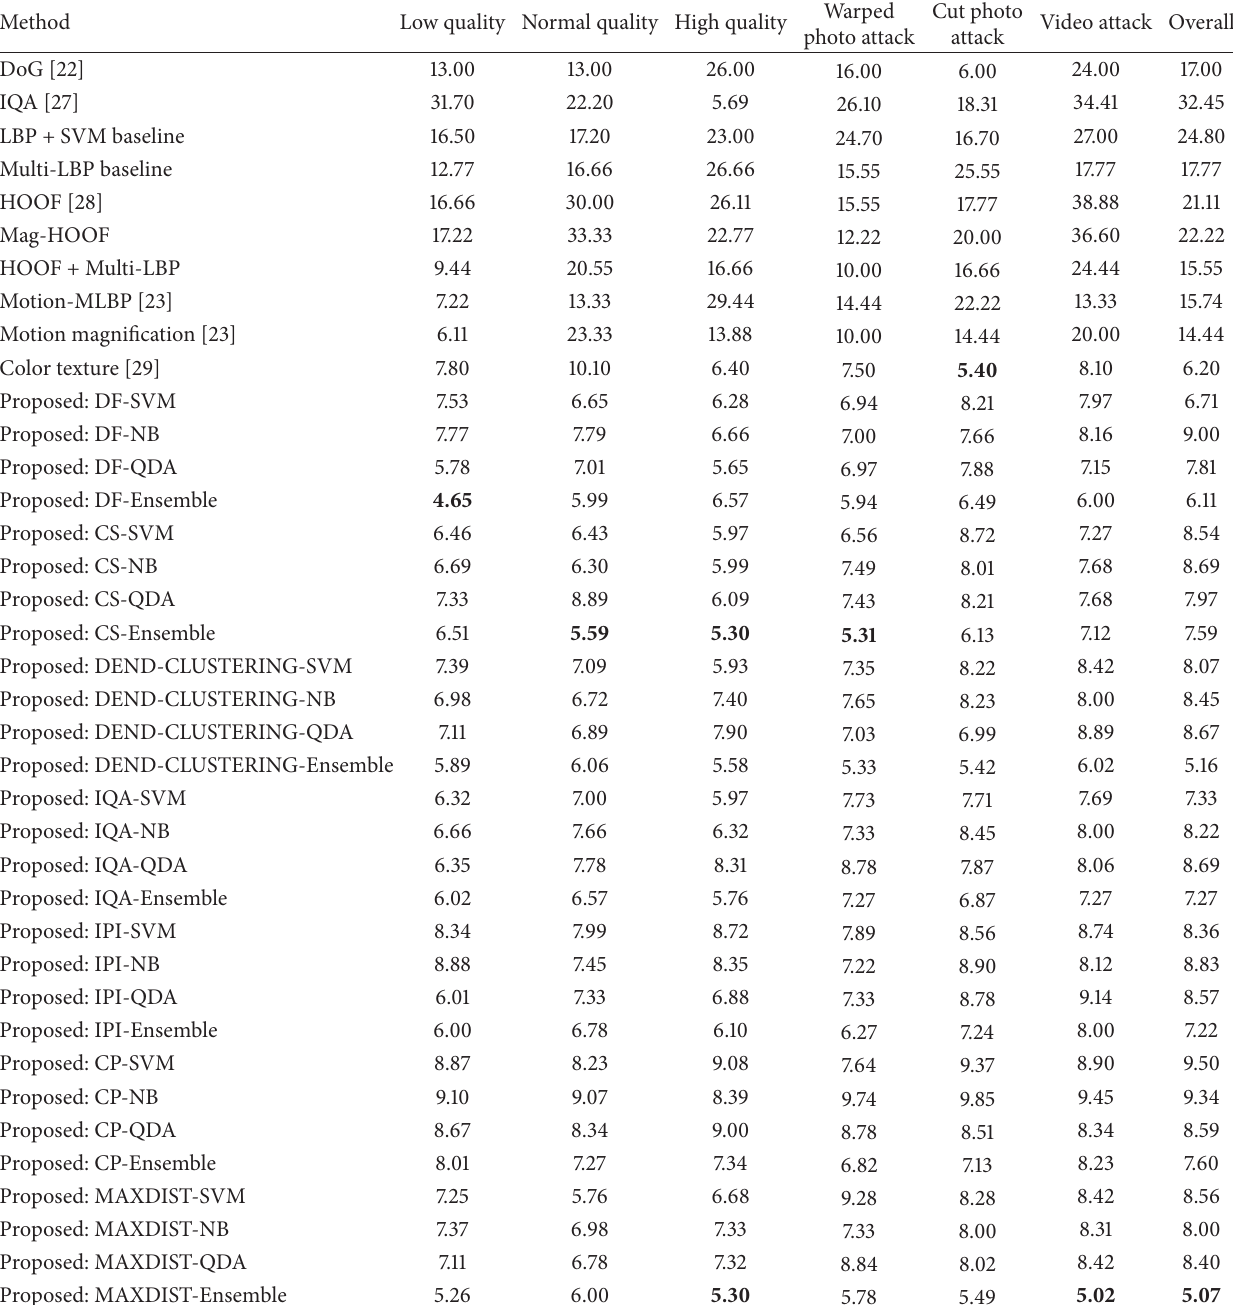
Table 4: Comparison of the proposed method (with SVM, QDA, Naive-Bayes (NB), and Ensemble based classifiers) on CASIA-FASD database with existing methods in terms of EER